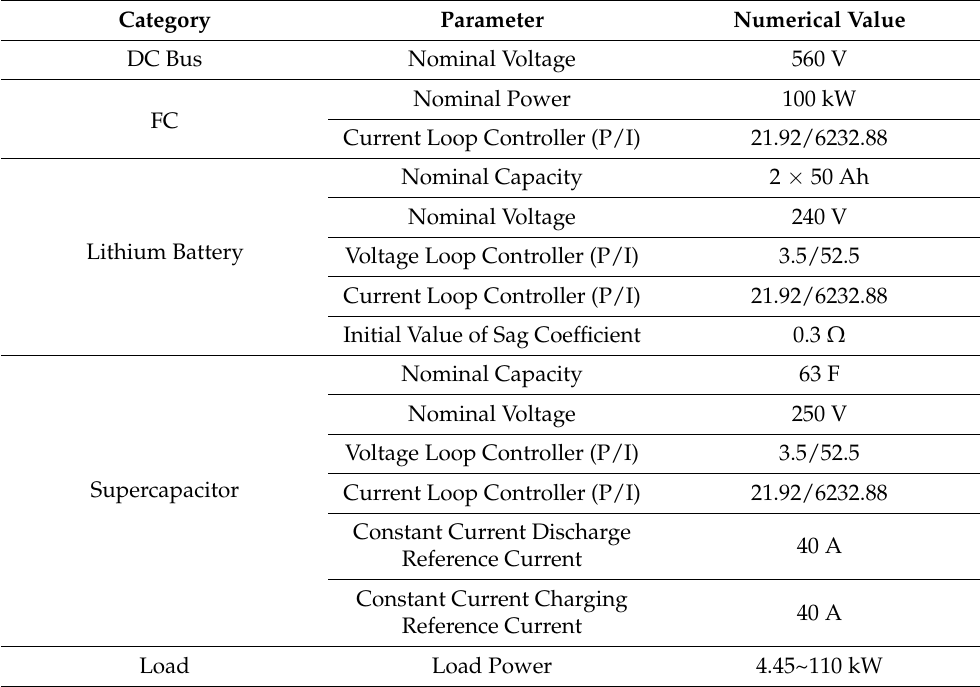
Table 6. Parameter setting table of the simulation model of the vessel hybrid power